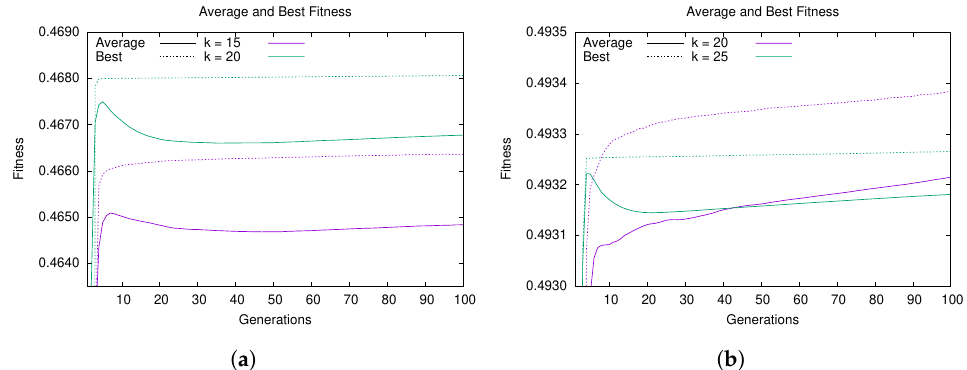
Figure 3. Convergence behavior of H YBRID -IA: dotted lines are for best values, continuous lines for average values. Average and best fitness value versus generations on ( a ) LFR(1000,15,0.5) and LFR(1000,20,0.5) , and on ( b ) LFR(5000,20,0.5) and LFR(5000,25,0.5) .